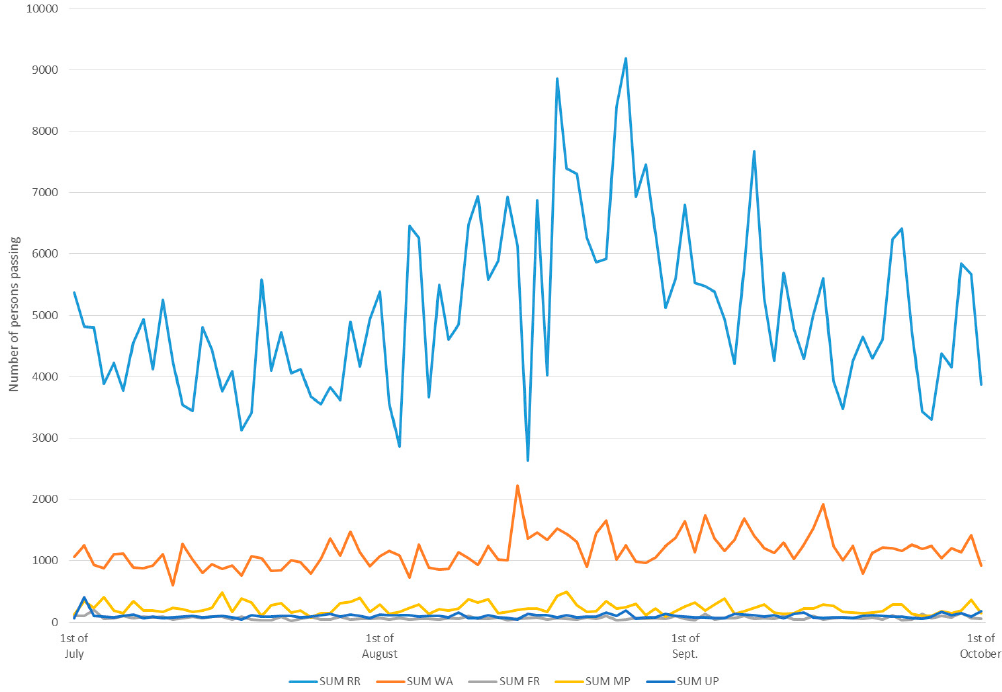
Figure 3. Sum of persons passing each day during 94 days in the months July, August and September as indicated by sum of counting sites in each ROS class. RR = Recreational roads; WA = walkways/bikeways; FR = Forest roads; MP = Marked path; UP = Unmarked path. Forests 2016 , 7 , 113 10 of 19 Survey data on people’s preferences from the national survey along the recreational infrastructure continuum show an opposite and increasing trend from developed areas to natural areas. All values and all classes differ significantly.